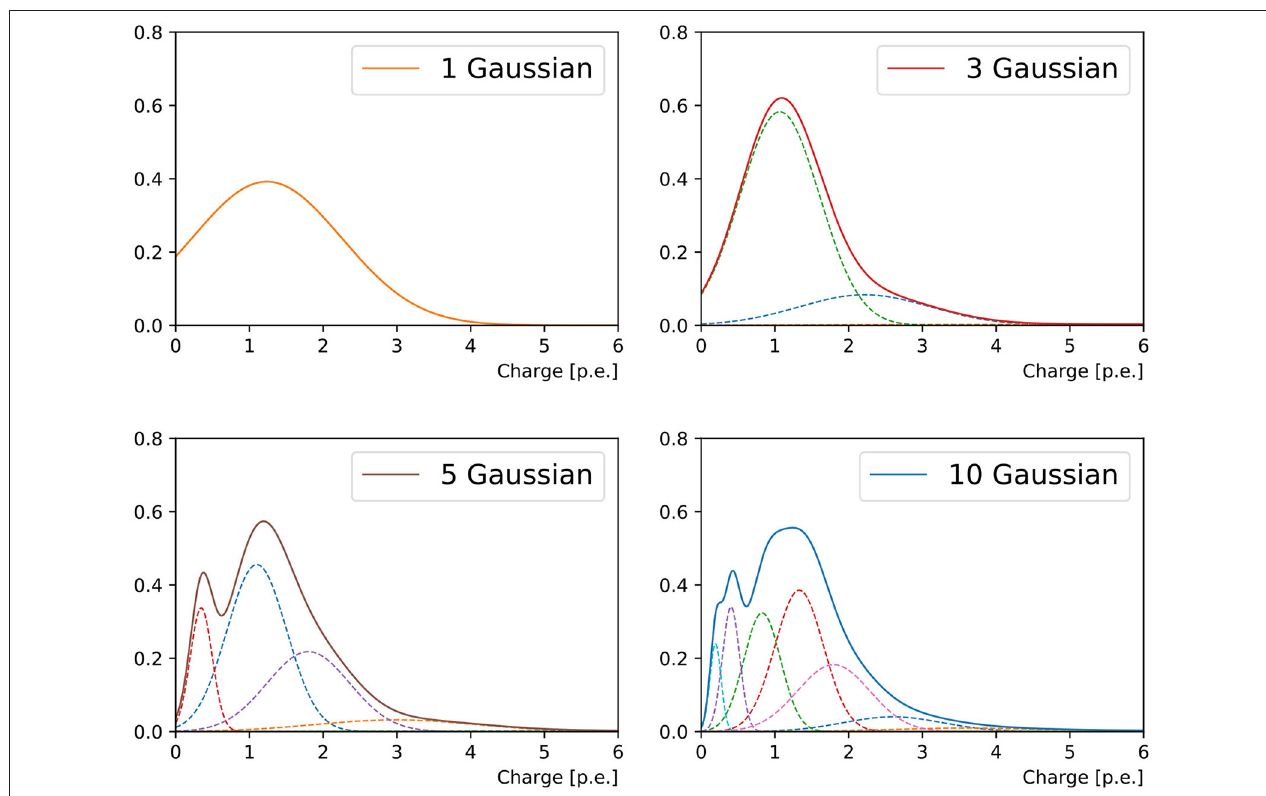
x direction. From the +